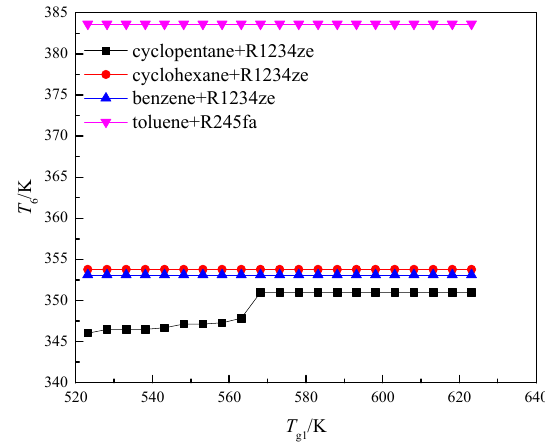
Figure 9. Effects of T g1 on the optimal HTL condensation temperature.